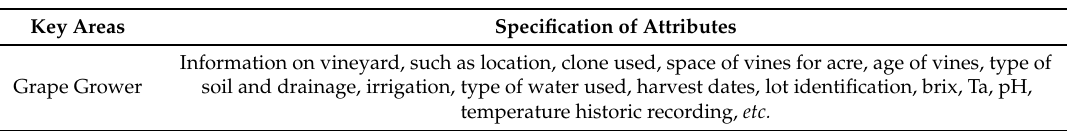
Table 2. The key areas in the wine supply chain adopted in the context of Albanian wine-making companies. Each area is associated with the information to be